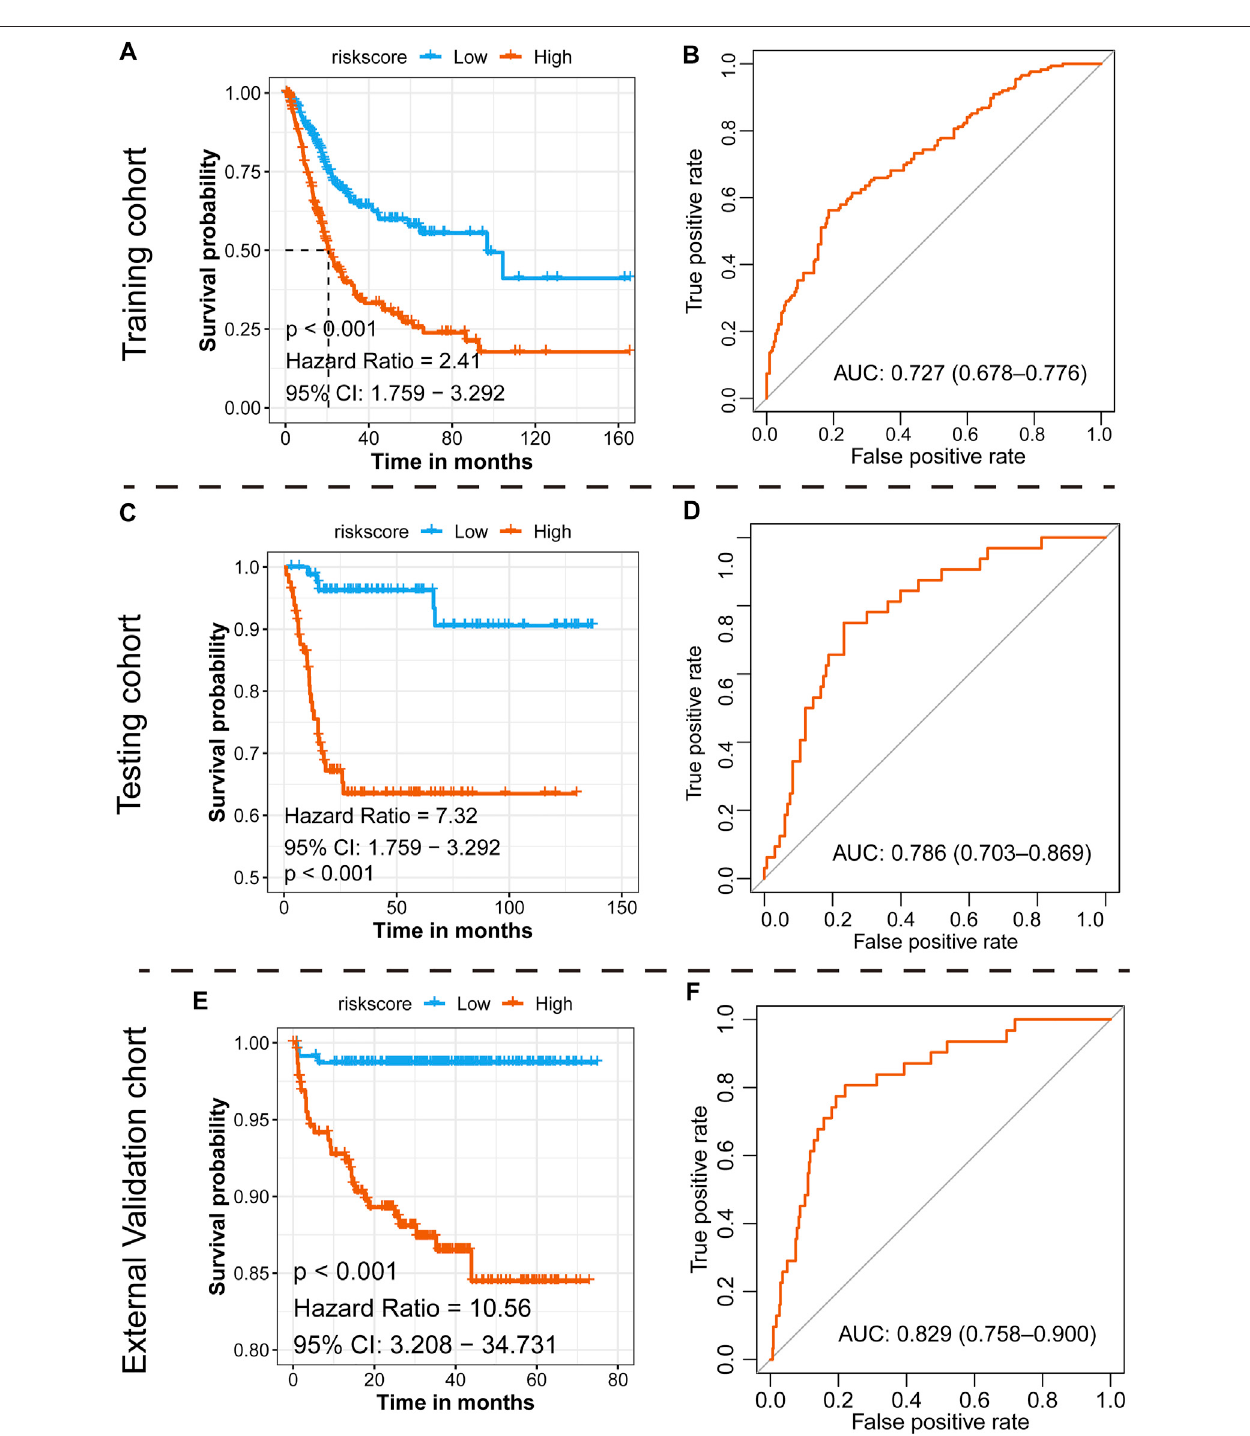
FIGURE5| Prognosticvalueofthenewlyde fi nedsignature. (A) K-Mplotshowingtheseparatedclinicaloutcomeofpatientsbelongingtothehigh-riskandlow-risk subgroups in the training TCGA-BLCA cohort (A) , testing GSE13507 cohort (C) , and external validation cohort (E) ; ROC curve showing the prognostic value of the signature in the training TCGA-BLCA cohort (B) , testing GSE13507 cohort (D) , and external validation cohort (F) .